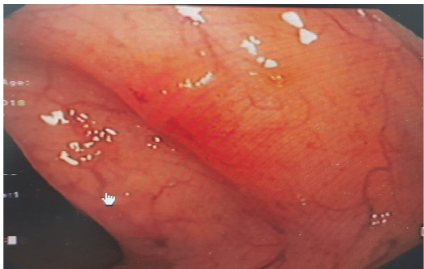
Figure 2: Colonoscopy showed mild patchy erythema at the descending and transverse colon, no ulcers or strictures, and normal terminal